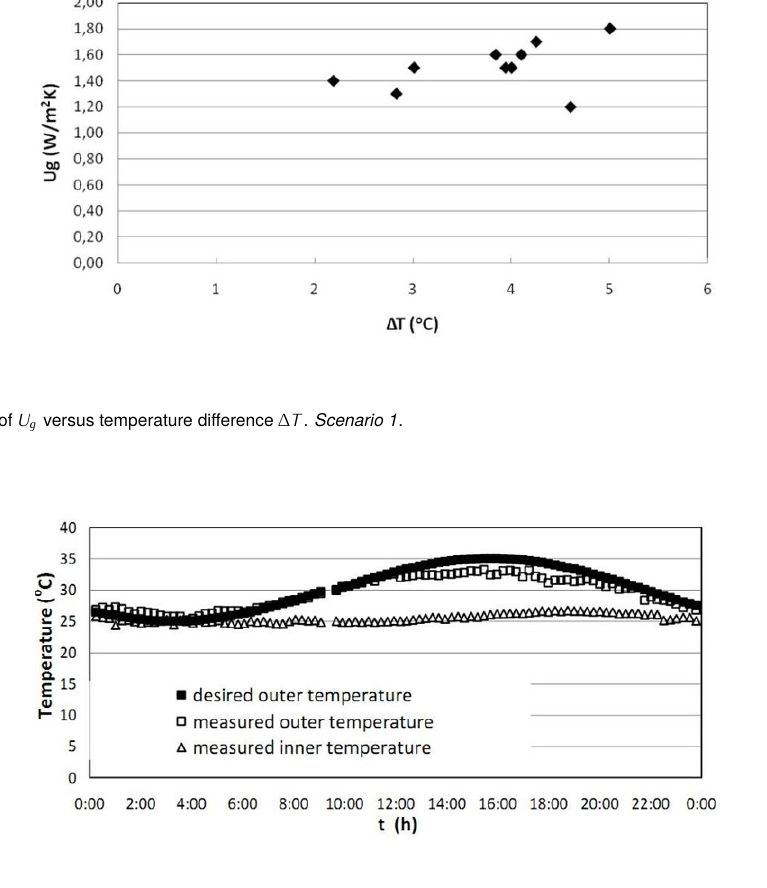
Figure 12. Temperature at the inner and outer side and desired temperature at the outer side. Scenario 2 .